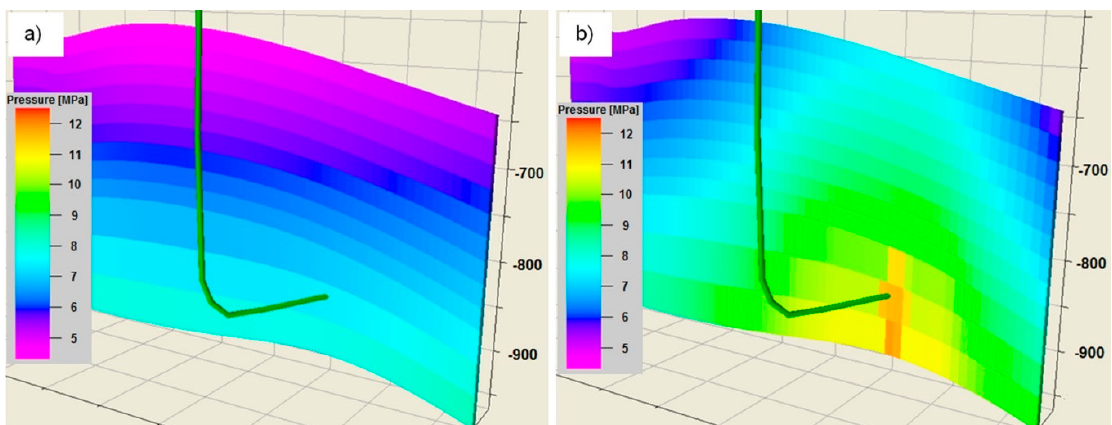
Figure 13. Changes in pressure across the injection zone—( a ) pressure distribution before starting injection and ( b ) pressure distribution after 25 years of injection.